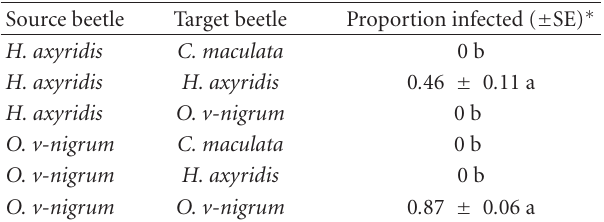
Table 1: Previously noninfected target lady beetles infected with the ectoparasitic fungus H. virescens when exposed in a Petri dish for 7 d to already infected source H. axyridis or O. v-nigrum lady